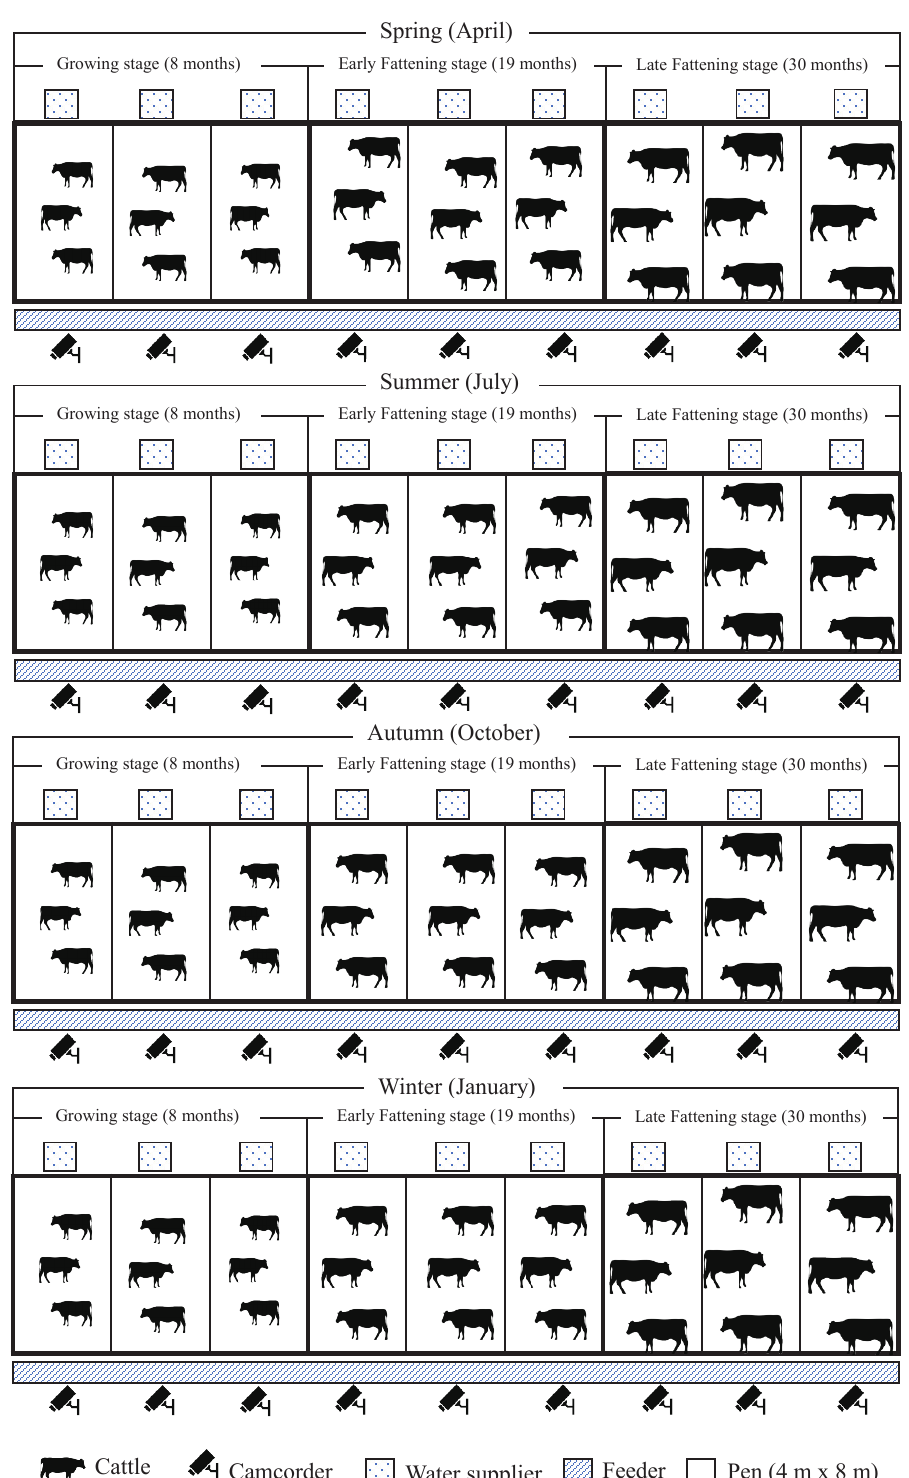
Figure 1. Experimental design of obseving behavior in Hanwoo steers as different growth sages and